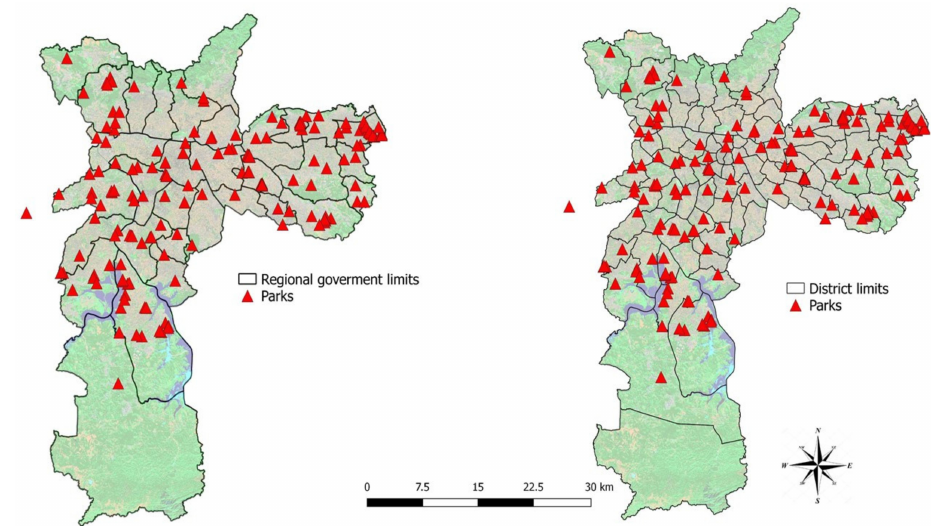
Figure 4. District and regional government boundaries exposure assessment and park